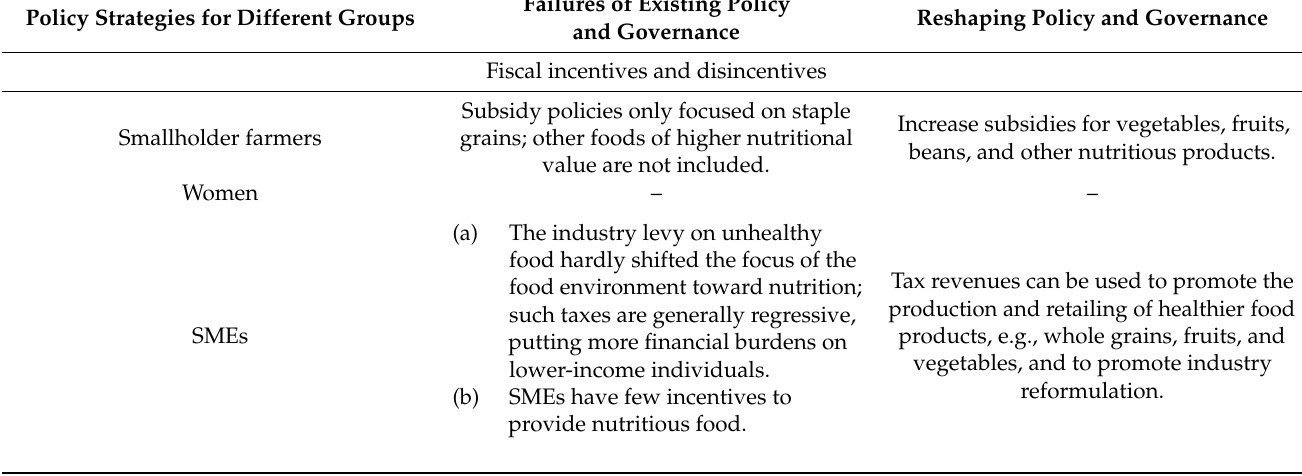
Table 1. Reshaping food policy and governance to empower smallholder farmers, women, and small- and medium-sized enterprises to improve